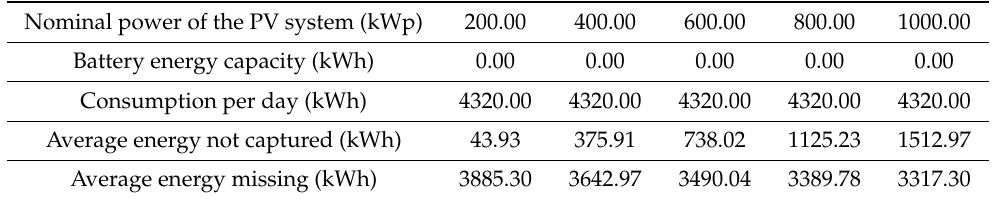
Table 3. Unused and missing energy for PV installations from 200 to 1000 kWp.